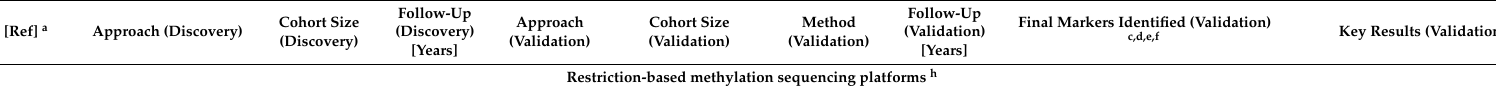
Table 2. Candidate (a priori) prognostic methylated tissue-based biomarker